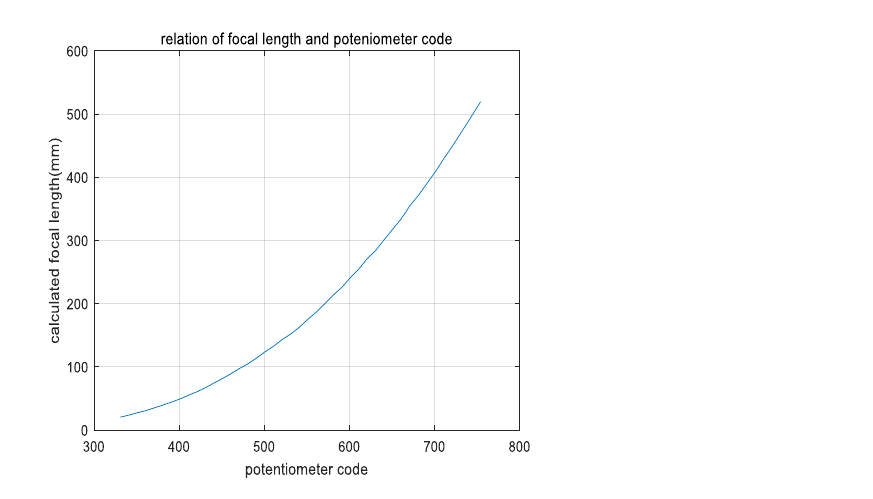
Figure 9. Relation of the zoom potentiometer code values and focal length.